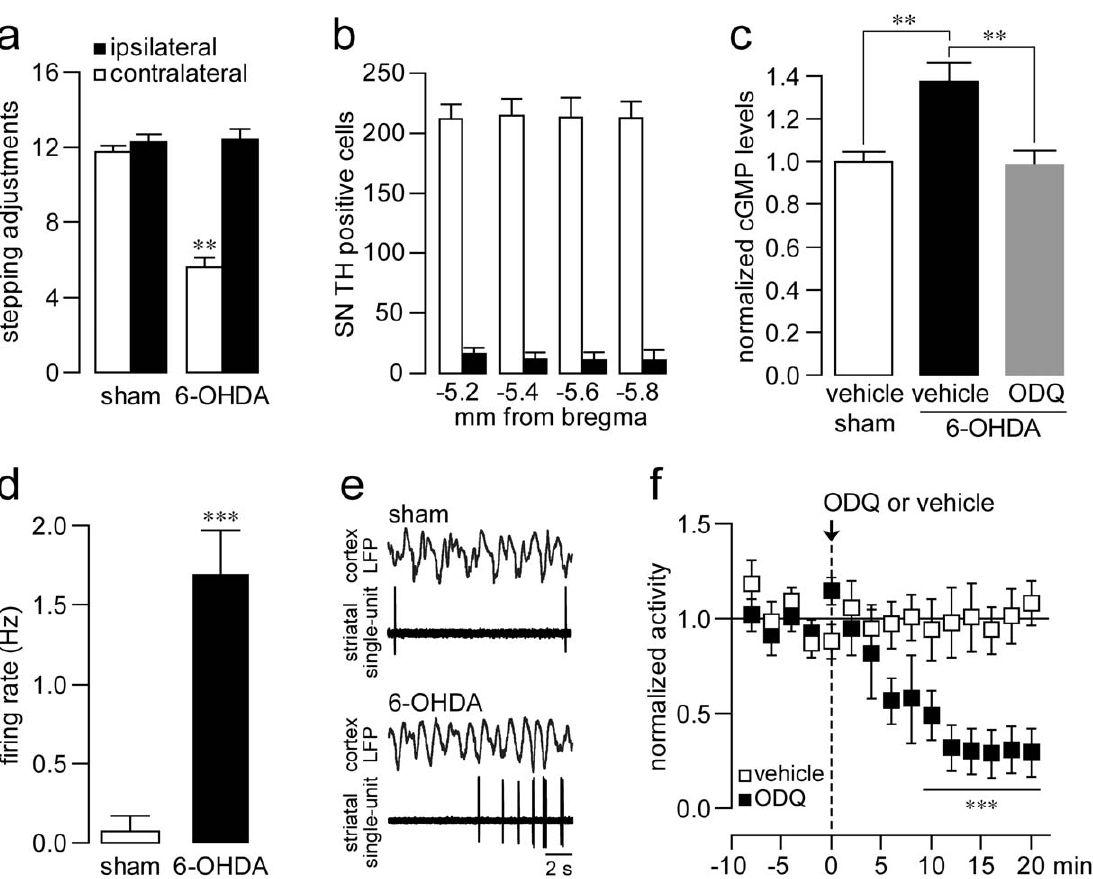
Figure 2. Systemic administration of the sGC ODQ reverses the increased striatal cGMP levels and the elevations in striatal activity observed in 6-OHDA-lesioned rats. ( a ) Behavioral assessment of 6-OHDA-induced unilateral nigrostriatal DA cell lesions. Compared to sham- operated controls (n=11), all 6-OHDA-lesioned rats included in this study (n=19) exhibited significant impairments in contralateral forelimb adjustment steps (*** P , 0.0005 , unpaired t-Test), ( b ) Cell counting of TH positive neurons in the SN at four anatomical levels indicated that the degree of DA cell loss observed in all 6-OHDA-lesioned rats included in this study was . 90%. ( c ) Striatal tissue cGMP levels were assessed in sham and 6-OHDA-lesioned rats pretreated with vehicle (n=5–6 per group) or the sGC inhibitor ODQ (20 mg/kg, i.p.). Chronic DA depletion increased striatal cGMP levels ( **P , 0.01 as indicated, Tukey post-hoc test after significant one-way ANOVA) in a manner that was reversed following a single ODQ treatment (1 hour post injection). ( d ) Bar graph summarizing the increased firing activity of striatal MSNs recorded from 6-OHDA-lesioned rats (n=25 cells/19 rats) relative to sham-operated controls (n=13 cells/11 rats) (*** P , 0.001 , unpaired t-Test). ( e ) Electrophysiological traces of simultaneously recorded striatal single-unit activity and cortical LFPs in a sham and a 6-OHDA-lesioned rat. ( f ) Time course showing the effects of one systemic administration of vehicle (n=5 cells from 5 rats) or ODQ (20 mg/kg, i.p., n=7 cells from 7 rats) on striatal single-unit activity recorded from 6-OHDA-lesioned rats. ODQ (but not vehicle) markedly reduced elevations in firing rate observed in cells recorded from 6-OHDA-lesioned rats ( ***P , 0.0005 , compared to pre-ODQ activity or to measures taken at identical time points as indicated, Tukey post-hoc test after significant ANOVA).